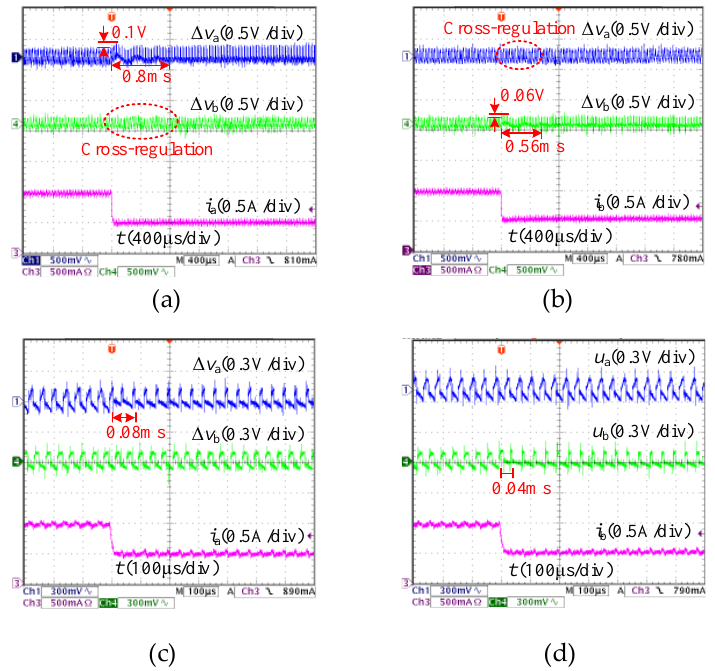
Figure 12. Experimental waveforms of PCCM SIDO buck converter with output load step-down variation: ( a ) change i a under voltage mode control; ( b ) change i b under voltage mode control; ( c ) change i a under voltage ripple control; ( d ) change i b under voltage ripple control.